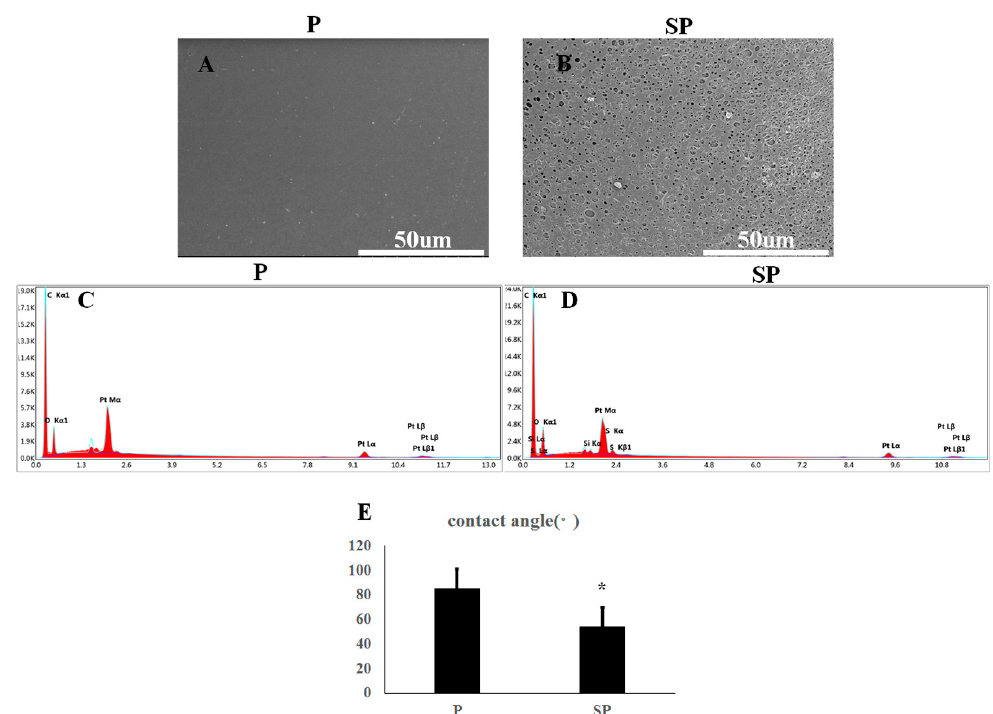
Figure 2. Surface characterization of peek specimens. SEM images of peek specimen ( A ) P and ( B ) SP. Elemental components of peek specimens ( C ) P and ( D ) SP determined by XDS. Water contact angles of peek specimens ( E ) P and ( F ) SP.* p < 0.05.